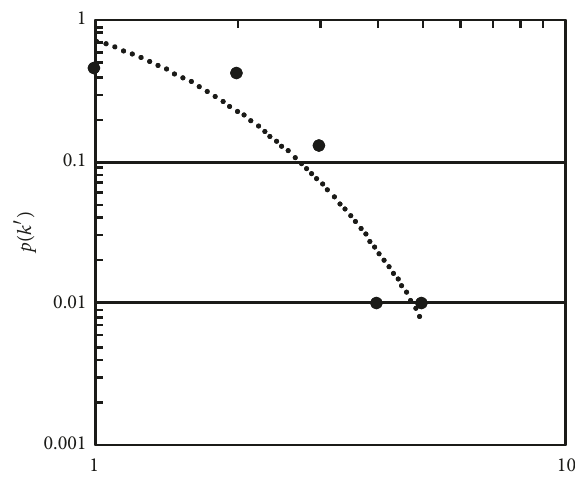
Figure 10: The distribution of VLs in the logarithmic graph (the vertical axis represents occurrence probability, and the horizontal axis represents the frequency of